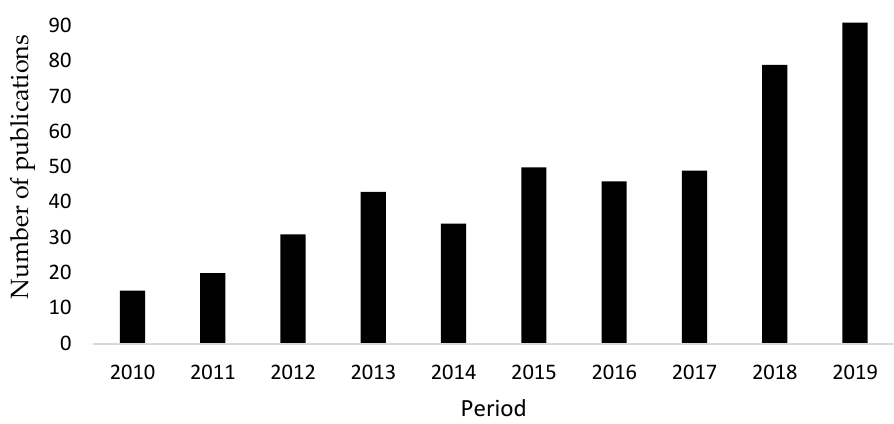
Figure 3. The number of publications on the research platforms (2010–2019) addressing the search terms “emergy” and